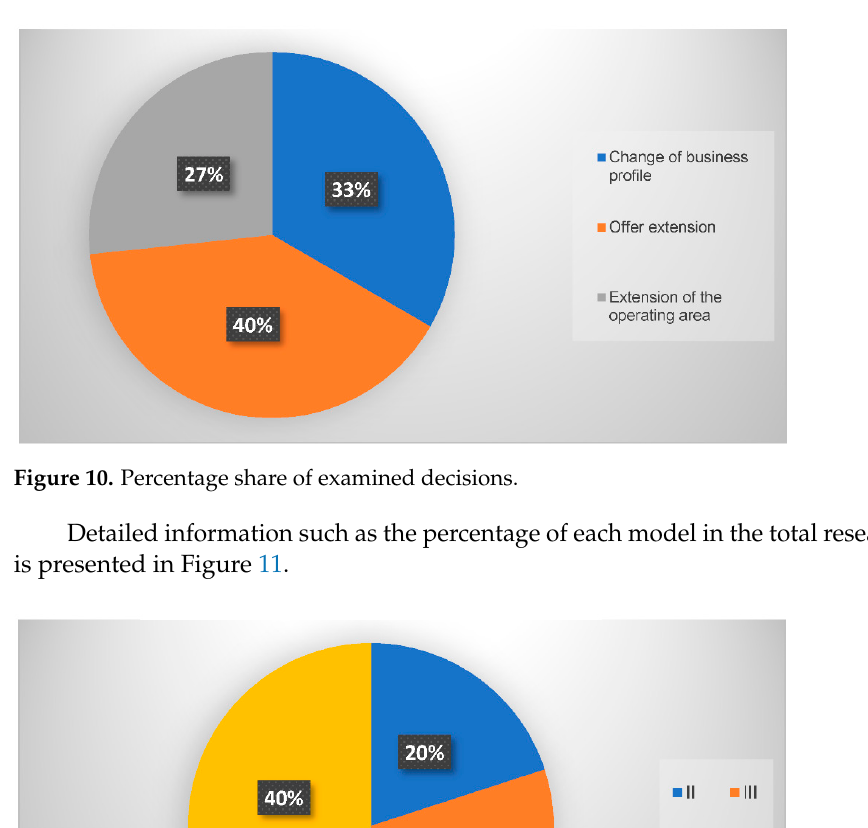
Figure 10. Percentage share of examined decisions.